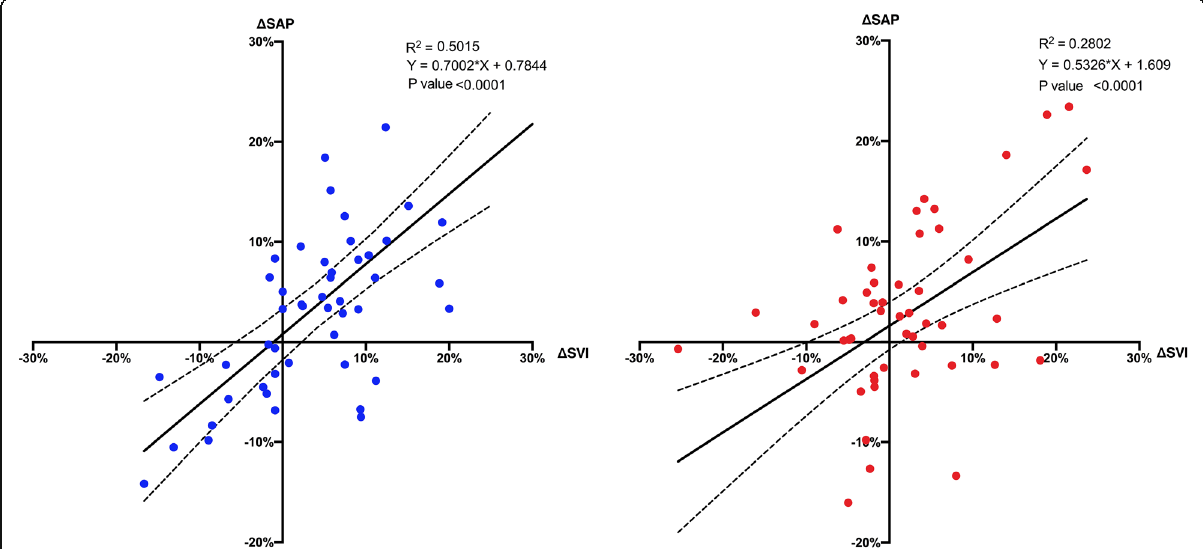
Fig. 1 Linear regression between the changes in SVI ( Δ SVI) and in SAP ( Δ SAP) after ½ fluid challenge administration in the FC 10 (blue dots, left panel) and FC 20 (red dots, right panel). Dashed lines represent 95% confidence intervals for the regression line (solid